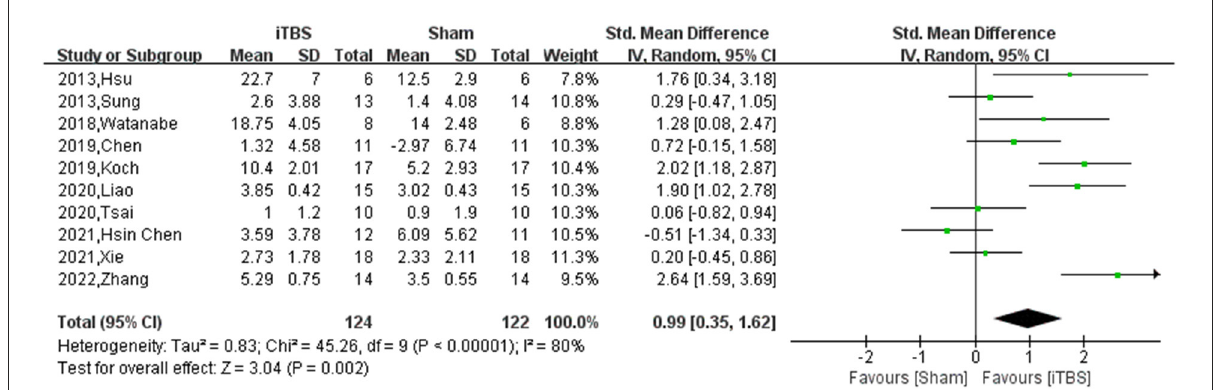
FIGURE2 The pooled Std.MD of FMA change from baseline. The green square indicates the estimated Std.MD for each RCT. The size of the green square indicates the estimated weight of each RCT, and the extending lines indicate the estimated 95% CI of Std.MD for each RCT. The black diamond indicates the estimated Std.MD (95% CI) for all patients.